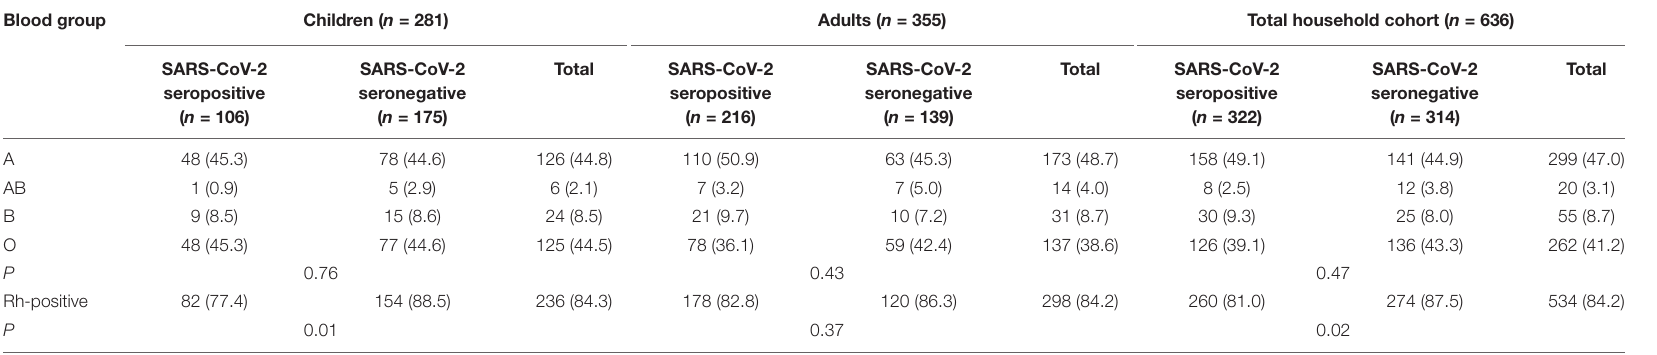
TABLE 2A | Blood type distribution within the cohort among SARS-CoV-2 seropositive and seronegative children and adults.